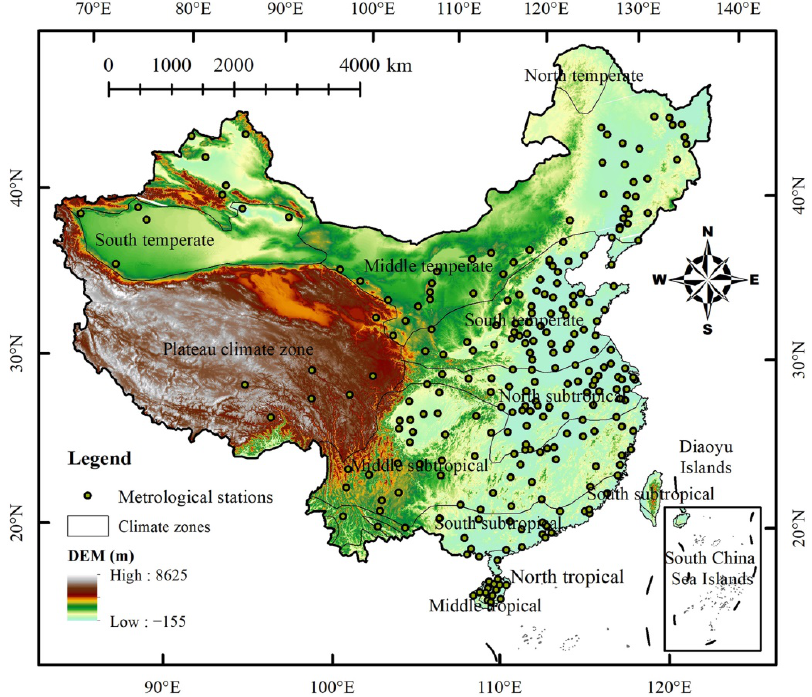
Figure A1. Location of the metrological stations. DEM, Digital Elevation Model.